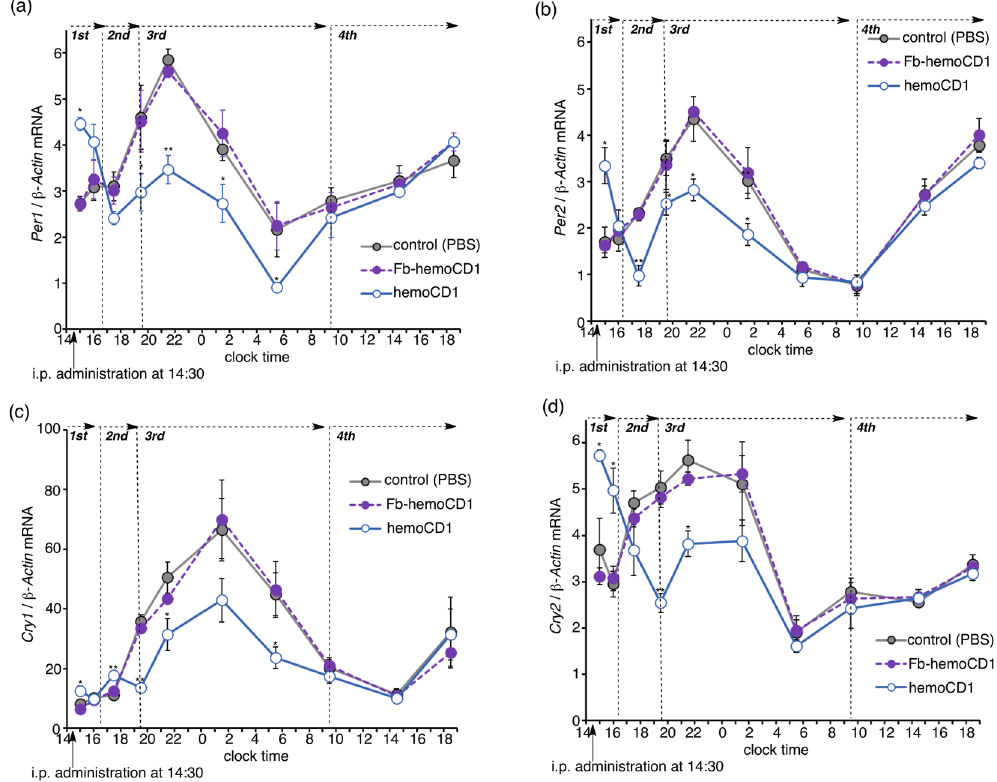
Figure 3. Changes in the mRNA levels of clock genes ( Per1 , a ; Per2 , b ; Cry1 , c ; Cry2 , d ) in the murine liver after i.p. administration of hemoCD1 at clock time 14.5 (14:30). PBS and Fb-hemoCD1 were similarly administered as control samples. Each bar represents the mean ± SE ( n = 3 mice per group). The mice were housed for two weeks under a 12 h light/dark (LD) cycle (lights on at 7:00 and light off at 19:00) until the day before the experiments. The mice were then housed under constant dark (DD) conditions during the observations. Asterisk denotes statistical significance ( * P < 0.05, ** P < 0.01), as compared to the controls. Note that the value on the vertical axis cannot be directly compared between the different panels (a–d) because the amount of cDNA used for real-time PCR varies with the gene of interest.